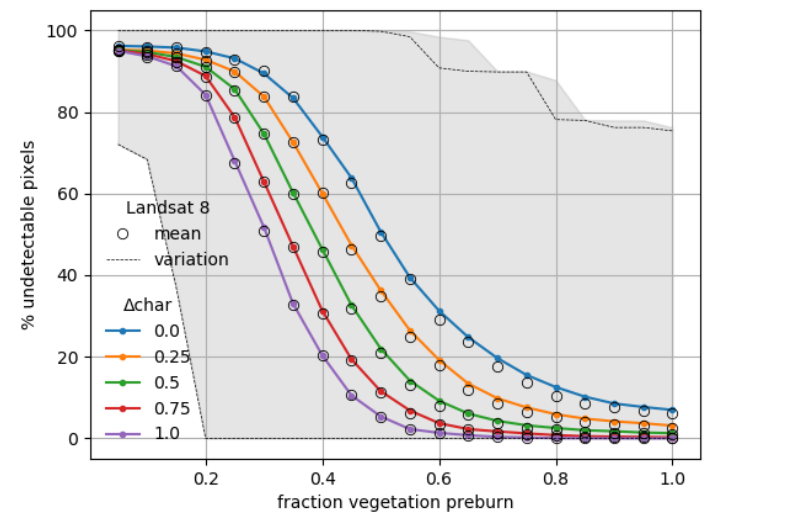
Figure A5. Percentage of undetectable pixels as a function of starting vegetation fraction and ∆ char parameter setting, park-wide for Sentinel-2A, dNBR threshold = 0.15. Mean values are shown in colored lines, with total model result variation shown in gray. To compare, the results for Landsat 8 are shown in black, with mean values shown by circles and total model result variation shown by dashed